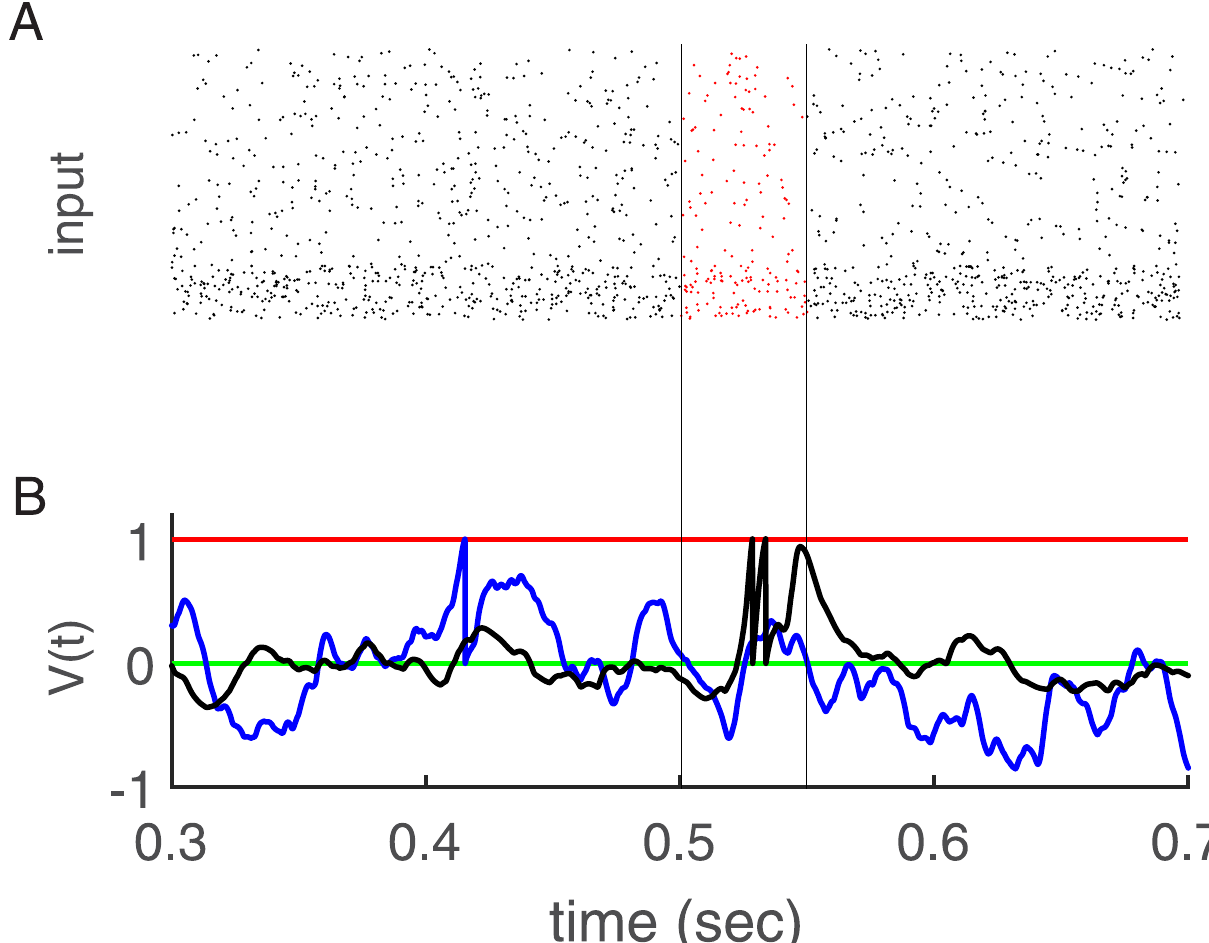
Fig 1. Learning of one embedded pattern. (A) Input activity in the raster plot. Five hundred afferents (80% excitatory and 20% inhibitory) send inputs to one post-synaptic neuron. The excitatory neurons’ rate is 5 Hz, and the inhibitory neurons’ rates are 20 Hz. There is a random embedded pattern of length 50 ms in the red area between black vertical lines. (B) Membrane potential versus time. The black trace shows that after learning the fluctuations outside of the embedded pattern are attenuated as compared to the case where the weights were learned from random background alone. As result two spikes occur during embedded pattern time (between the vertical black lines). The green line is for resting potential, red is for threshold, blue is membrane potential after weight initialization by learning with only random patterns, and black is for after